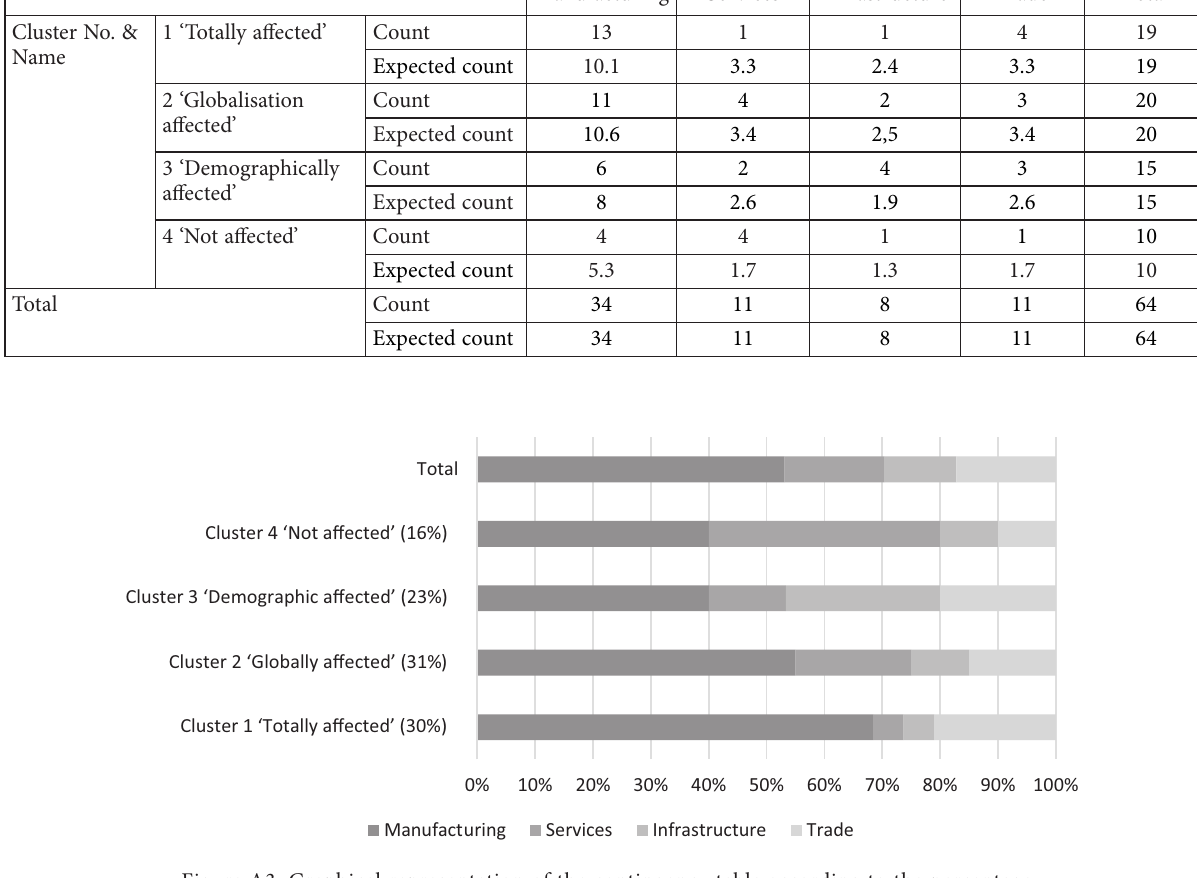
Figure A2. Graphical representation of the contingency table according to the percentage composition of the clusters divided into companies with <20.000 and >20.000 employees Table A2. Contingency table for the cluster solutions differentiated according to industry sector Manufacturing Services Infrastructure Trade Total